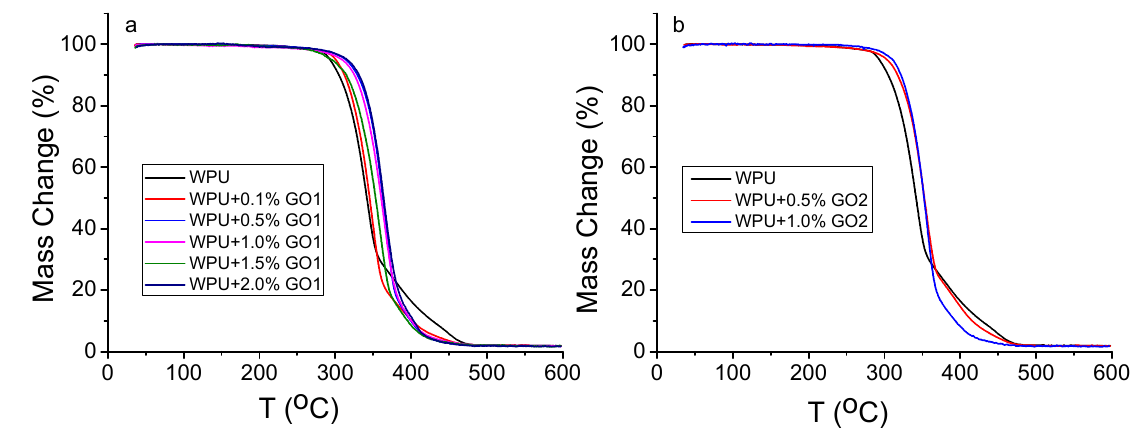
Figure 3. TG curves for WPU/GO1 ( a ) and WPU/GO2 ( b ) samples.